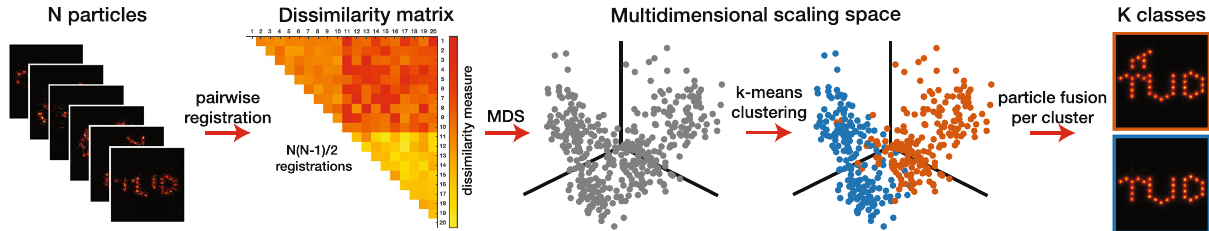
Fig. 1 Classi fi cation pipeline. N particles are pairwise registered, resulting in N ( N -1)/2 dissimilarity values. Multidimensional scaling (MDS) embeds the elements of the dissimilarity matrix in a multidimensional space (only the fi rst 3 dimensions are shown). K-means clustering in this space results in K clusters and the particles are fused per